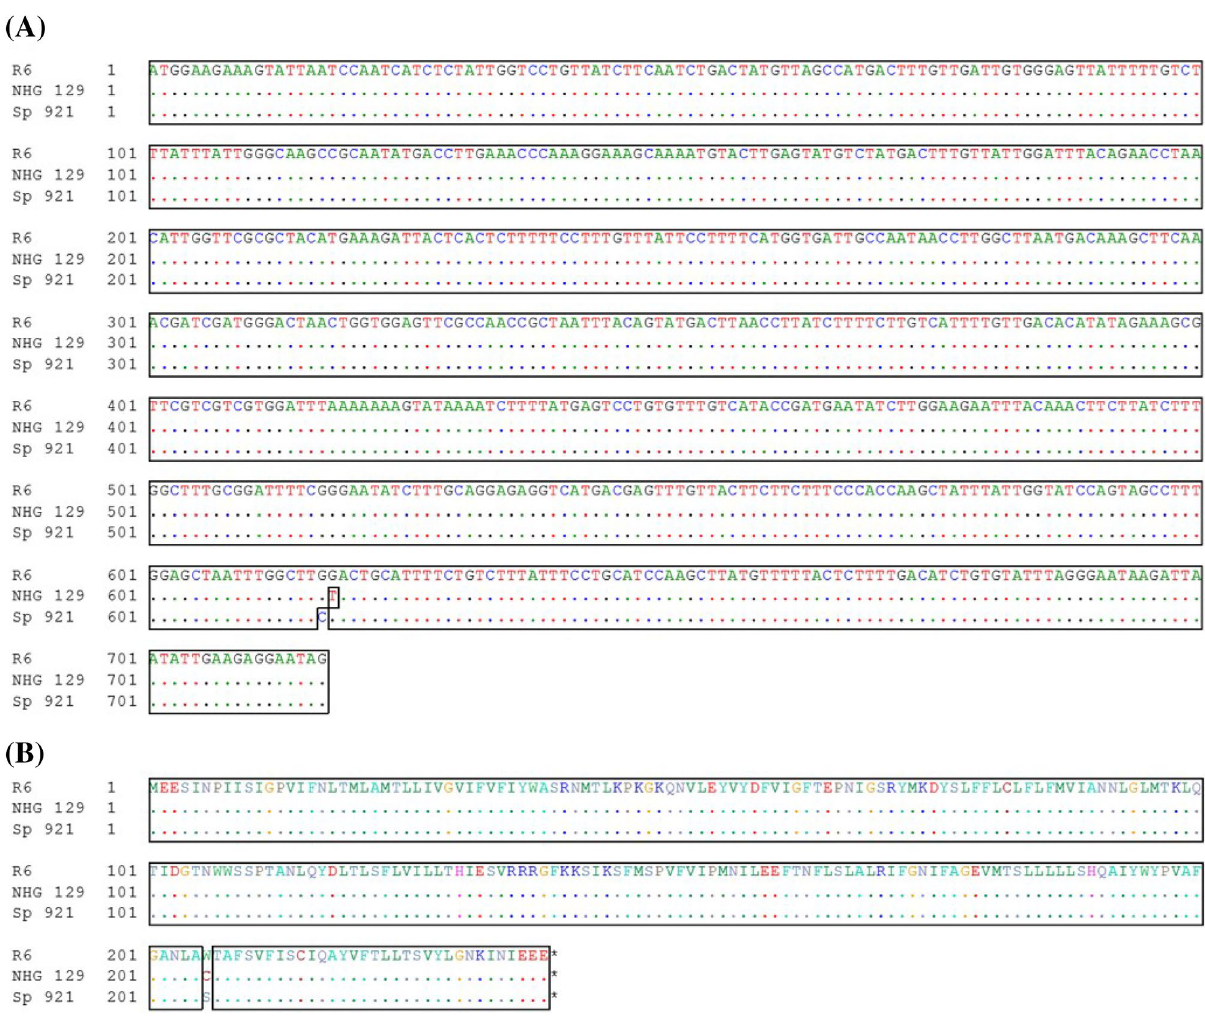
Figure 2. Alignment of representative atp A gene sequences observed among optochin-resistant (Opt r ) Streptococcus pneumoniae isolates. ( A ) Nucleotide sequences of the atp A gene representing the two different base-substitutions observed among the five Opt r isolates included in the present study. ( B ) Deduced amino acid sequences of the a-subunit of ATPase representing, respectively, the two different base-substitutions mentioned above. Optochin-susceptible reference strain S. pneumoniae R6 was included for comparative purposes. Alterations are outlined with black